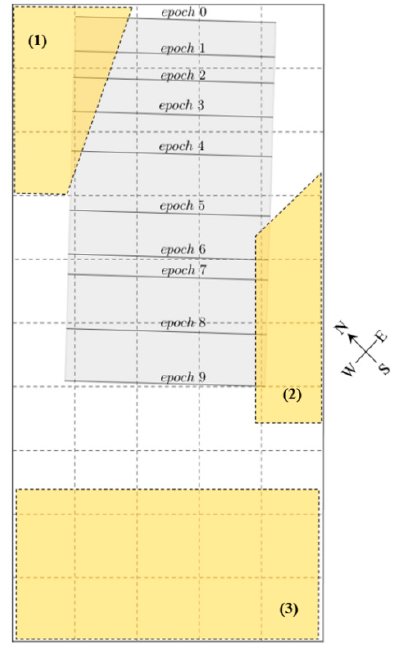
Figure 5. Areas of intensive terrain reclamation above the observed excavation (1, 2, 3).